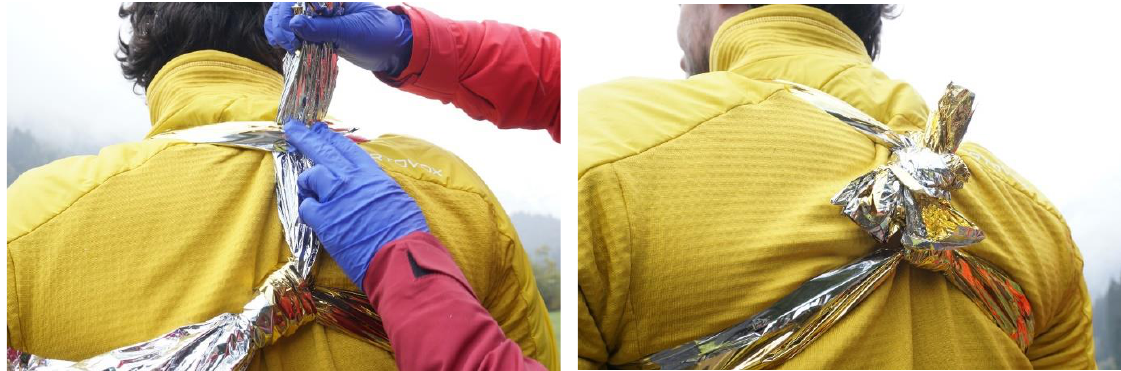
Figure 3. Application of a rescue blanket as figure-of-eight.